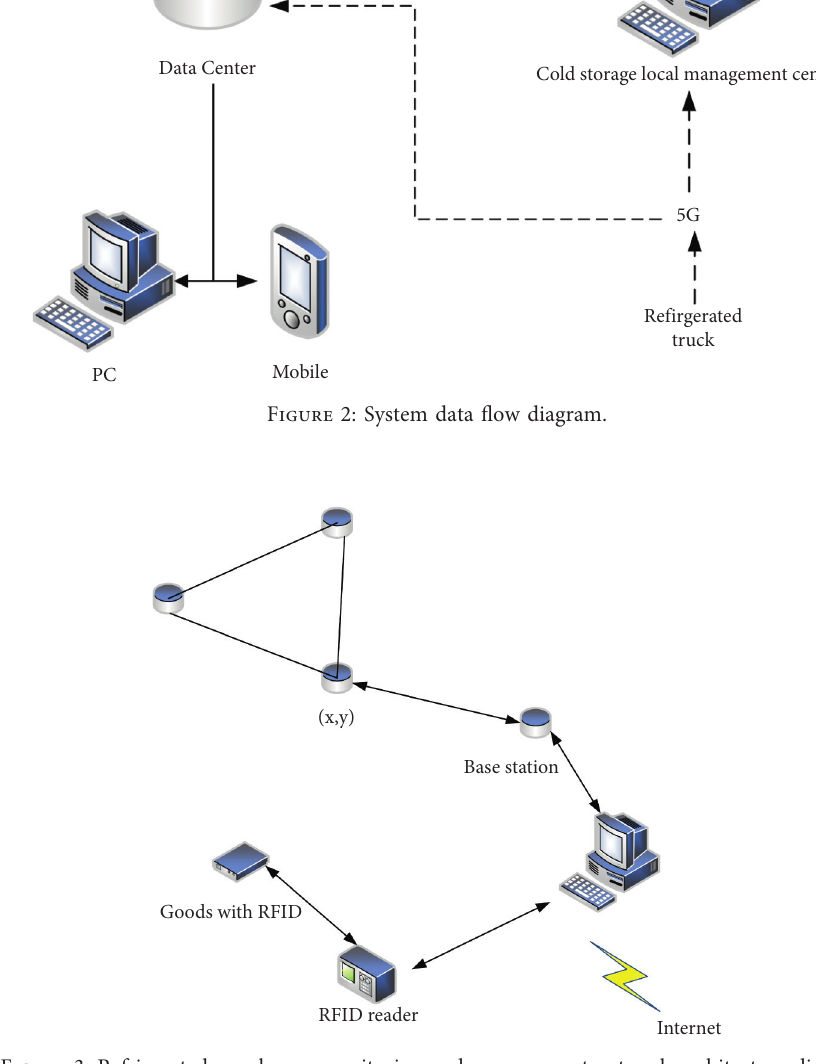
Figure 3: Refrigerated warehouse monitoring and management network architecture